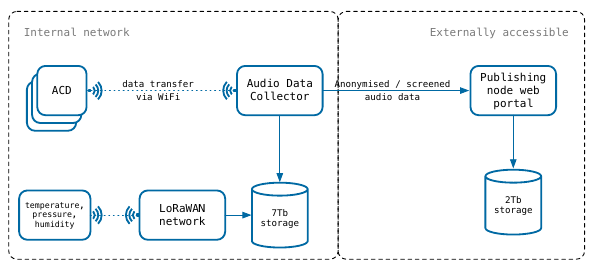
Figure 2. System architecture for collecting audio